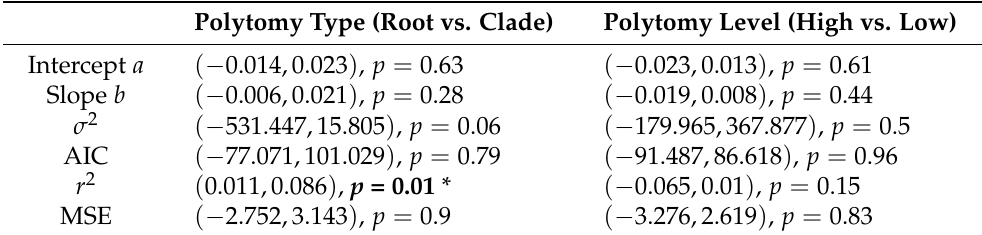
Table 2. Differences between polytomy types and levels. All results are insignificant (high p values are reported) except for comparing the r 2 between the root and clade ( p -value of